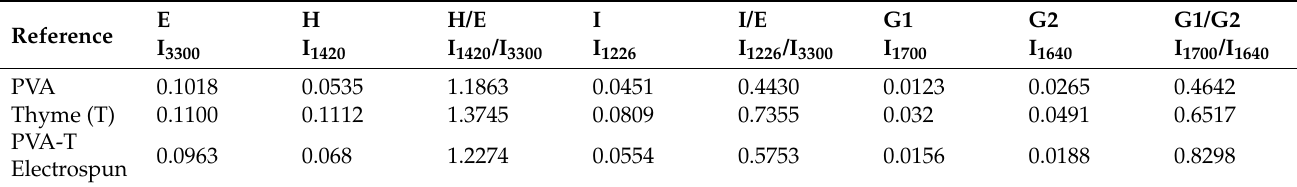
Table 8. Intensity of other characteristic bands of the FTIR spectrum of the less-relevant thyme- essential-oil nanofiber